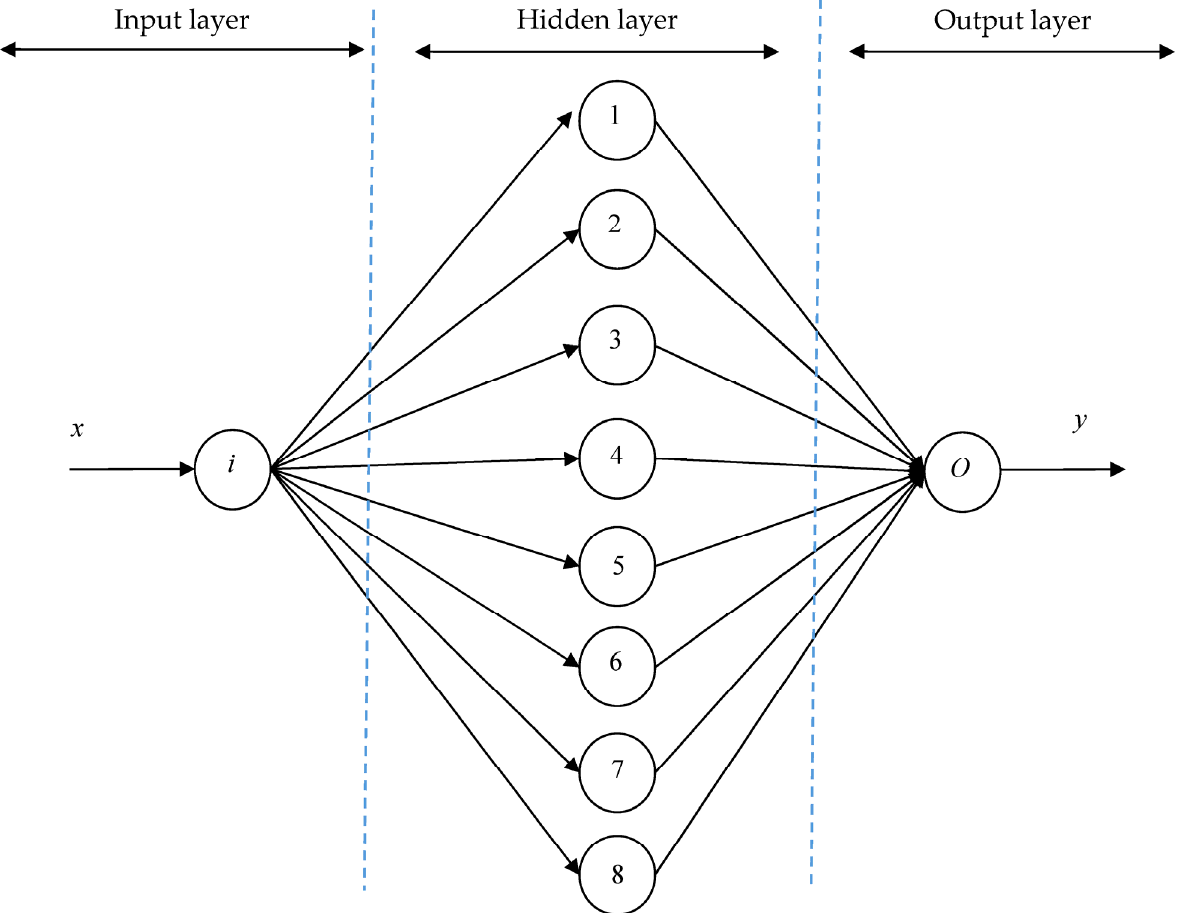
Figure A9. Structure diagram of the FNN in our designed learning-to-command model.